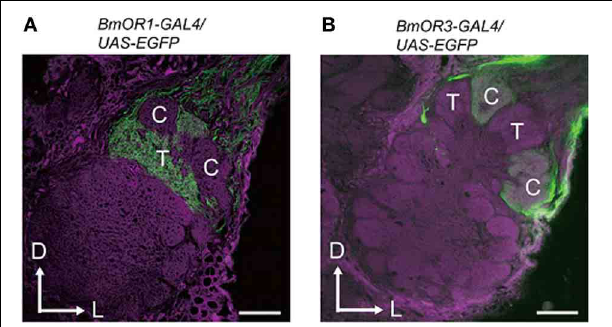
FIGURE 3 | Projection patterns of bombykol- or bombykal-sensitive ORNs to the AL. The axon terminals of bombykol (A) and bombykal (B) receptor neurons were labeled by EGFP using the BmOR1 or BmOR3 promoter-GAL4 lines and a UAS-EGFP line. EGFP was visualized using anti-GFP immunostaining (green). Background staining was carried out using Alexa Fluor 555 (magenta). Representative confocal sections are shown. C, cumulus; T, toroid; D, dorsal; L, lateral. Scale bars: 50 μ m. (modified from Sakurai et al.,